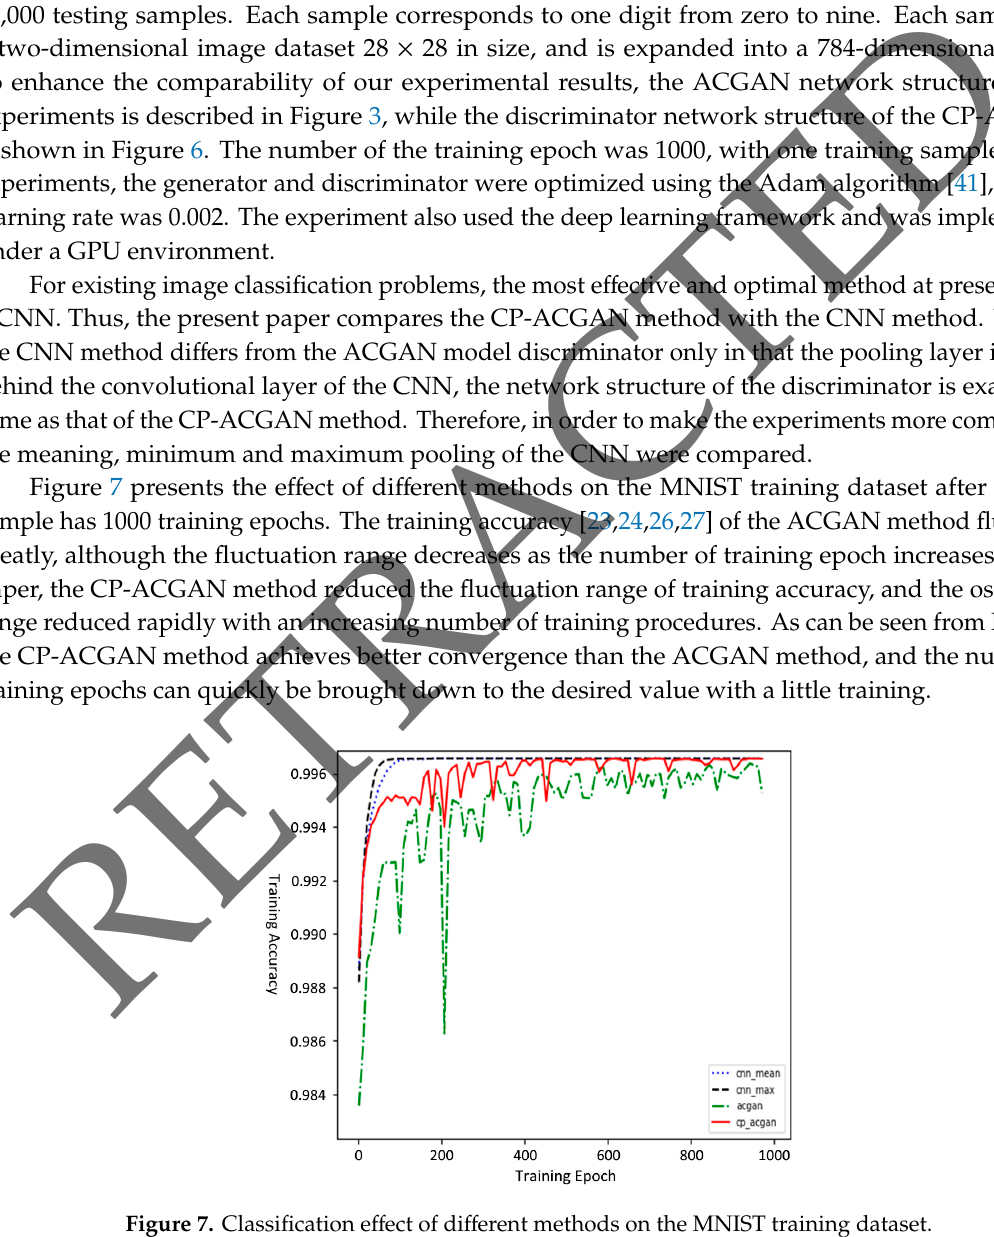
Figure 8. Testing accuracy comparison of different methods on the MNIST testing dataset. Table 1 presents the highest accuracy of the different methods on different datasets (MNIST, CIFAR10 and CIFAR100) after 1000 training epochs. Table 1. Best prediction accuracy of different methods on MNIST, CIFAR10, and CIFAR100. Model